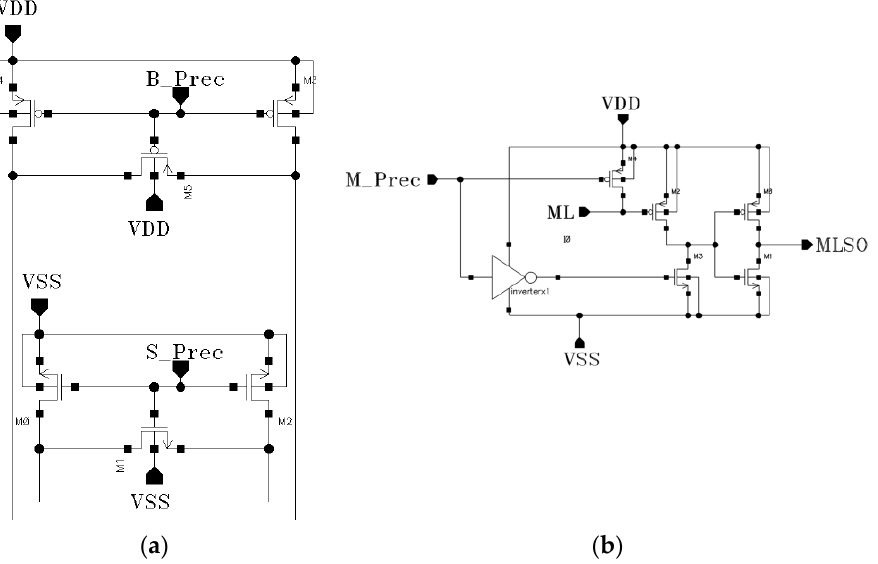
Figure 3. Precharge circuit of ( a ) bit line (BL) and search line (SL); and ( b ) match line (ML) [4,5].